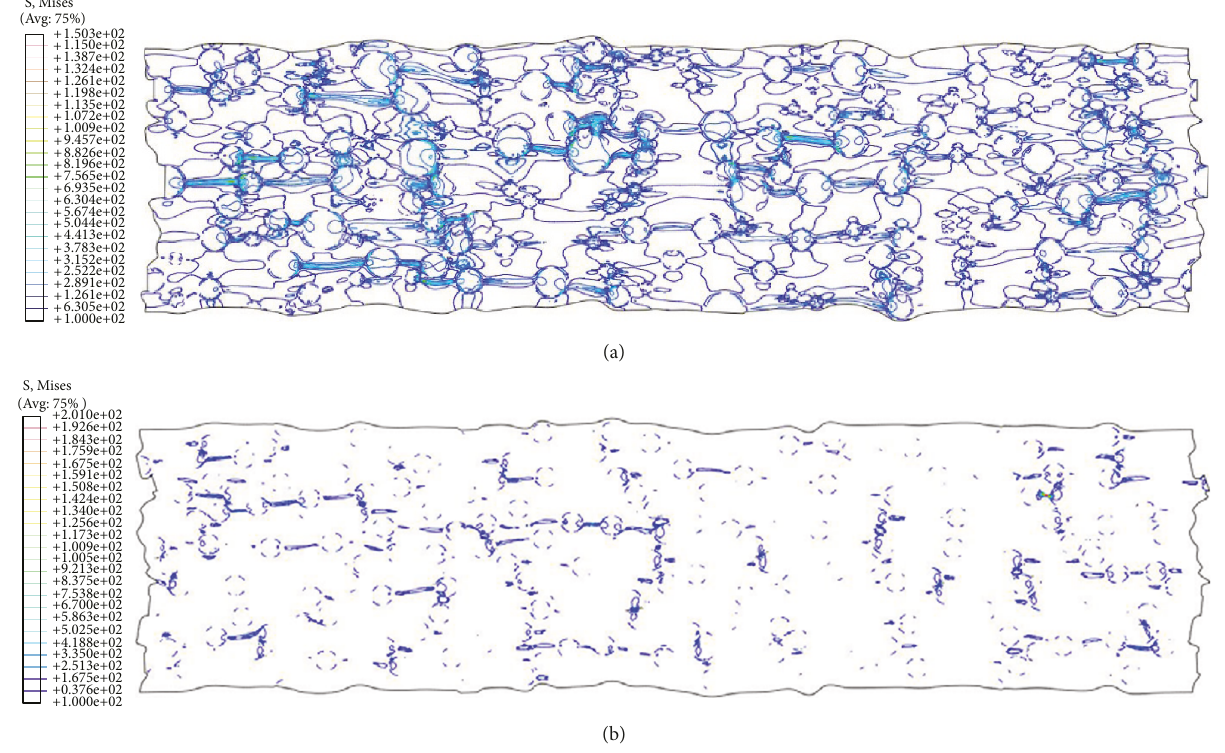
Figure 11: Deformation and distribution of Mises stress in two kinds of RVE models: ( ε = 1 ) (a) di ff erent particle size random model and (b) same particle size random